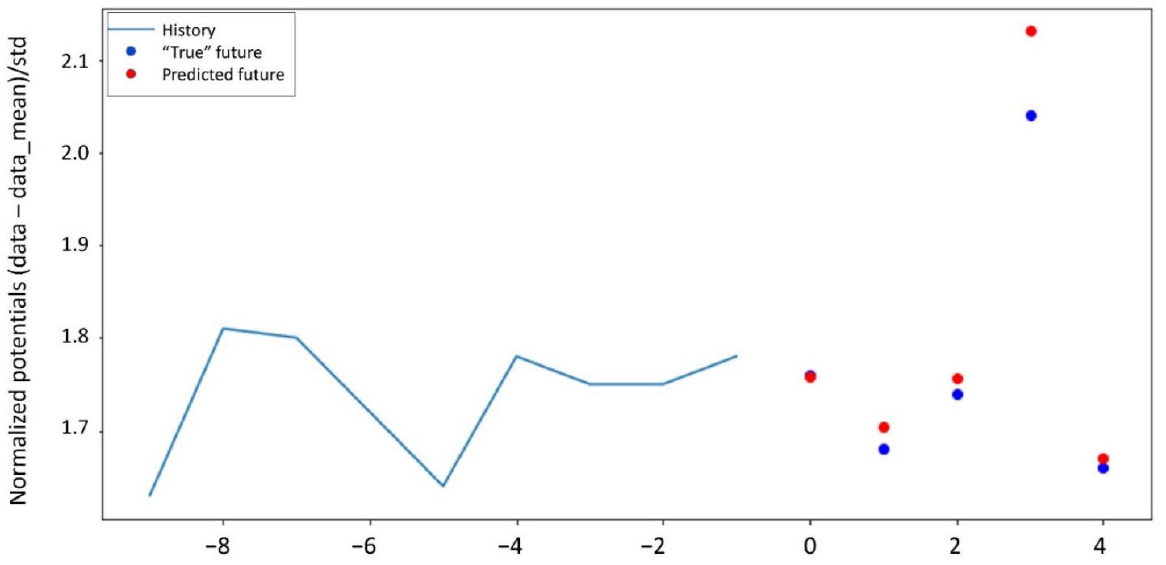
Figure 6. Chart of four predictions (predicted future) vs. observations (“true” future) for a single